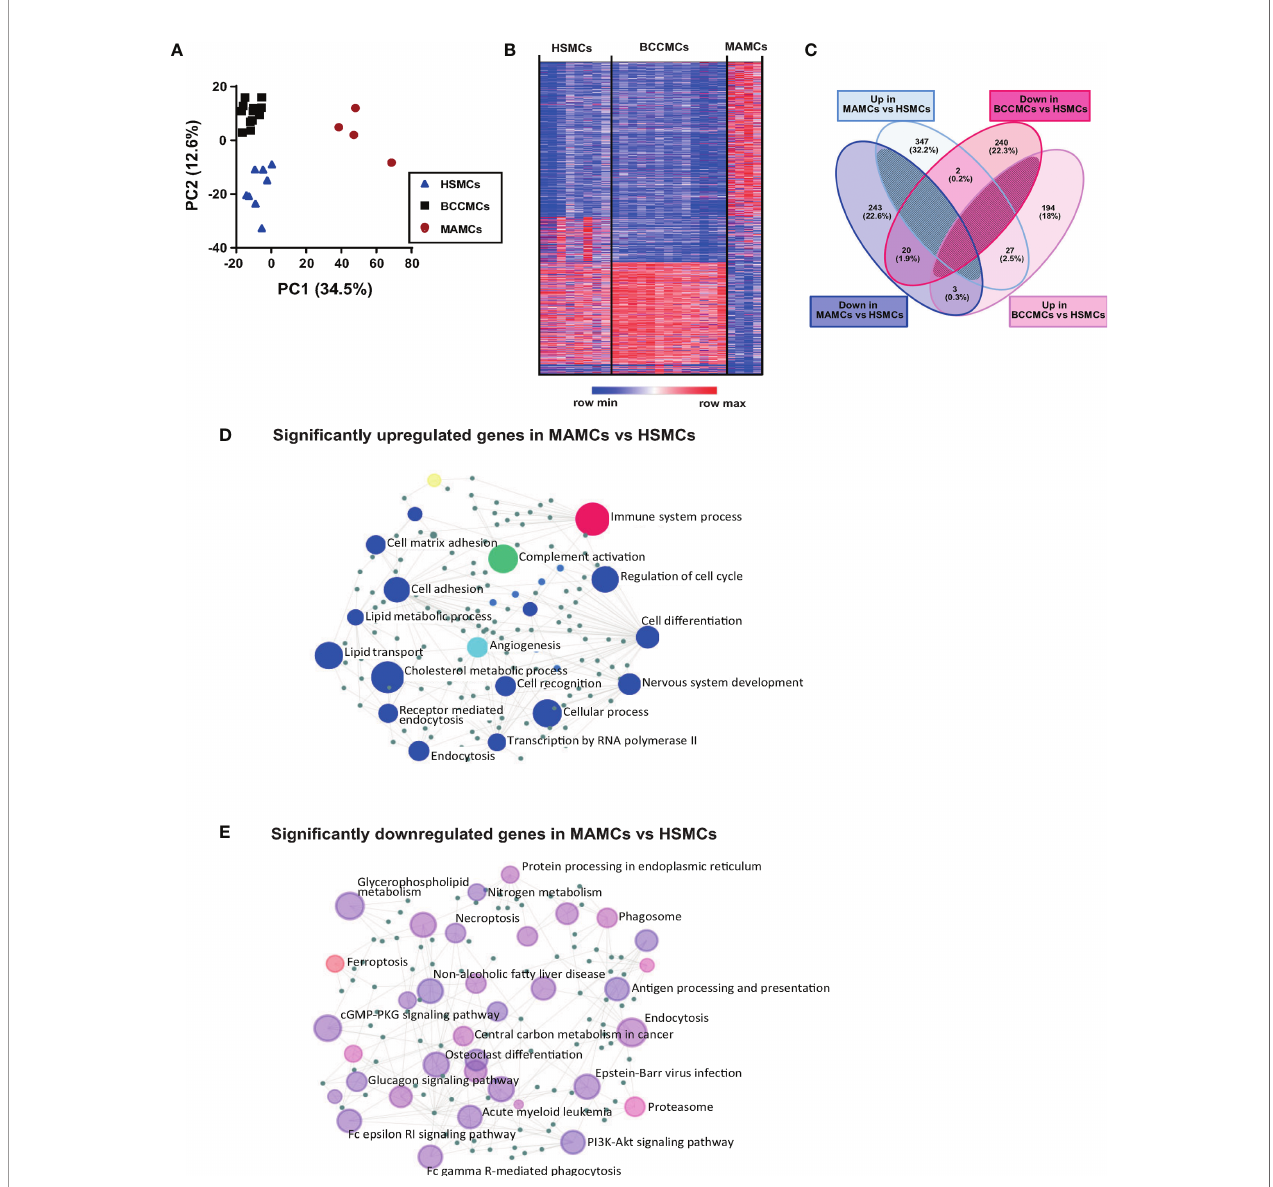
FIGURE 2 | Melanoma-associated mast cells (MAMCs) display a distinct and unique transcriptional signature. Mast cells were isolated by fl ow cytometry from 8 healthy skin (HSMCs), 13 BCC (BCCMCs), and 4 melanoma (MAMCs) biopsies. The RNA was extracted and the Illumina RNA-seq analysis was performed. (A) Principal component analysis (PCA) biplot of gene expression data where each biopsy condition is represented by a symbol: HSMCs in blue triangles, BCCMCs in black squares, and MAMCs in red circles. (B) Heat maps of changes in expression values of genes in MCs isolated from healthy skin, BCC, and MEL; red to blue scale bar indicated the z -score of fold change per genes (red indicates higher z -score, blue indicates lower z -score). Each row indicates an individual gene and each column a sample. (C) Venn diagram displays signi fi cantly up- and downregulated transcripts in BCCMCs (pink) and MAMCs (blue) versus HSMCs. Numbers represent gene numbers in different groups. (D) Network visual analysis of enriched gene ontology categories for signi fi cantly upregulated and downregulated (E) genes in MAMCs compared with HSMCs. Each circle represents a group of genes from the same biologic